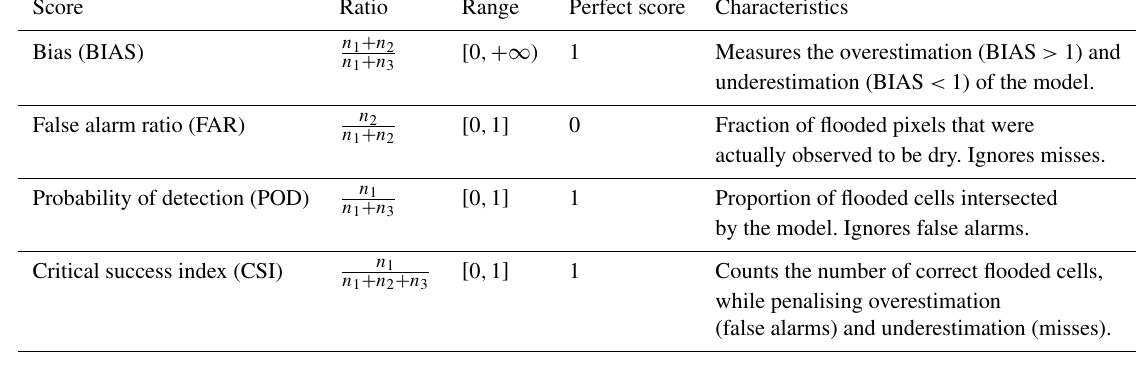
Table 3. Table of forecast scores used to assess the performance of a flood simulation. All criteria are based on the contingency table (Fig. 8) and reflect one characteristic of the model. Taken together, they provide a comprehensive analysis of the model’s behaviour. Score Ratio Range Perfect score Characteristics Measures the overestimation (BIAS > 1) and underestimation (BIAS < 1) of the model.